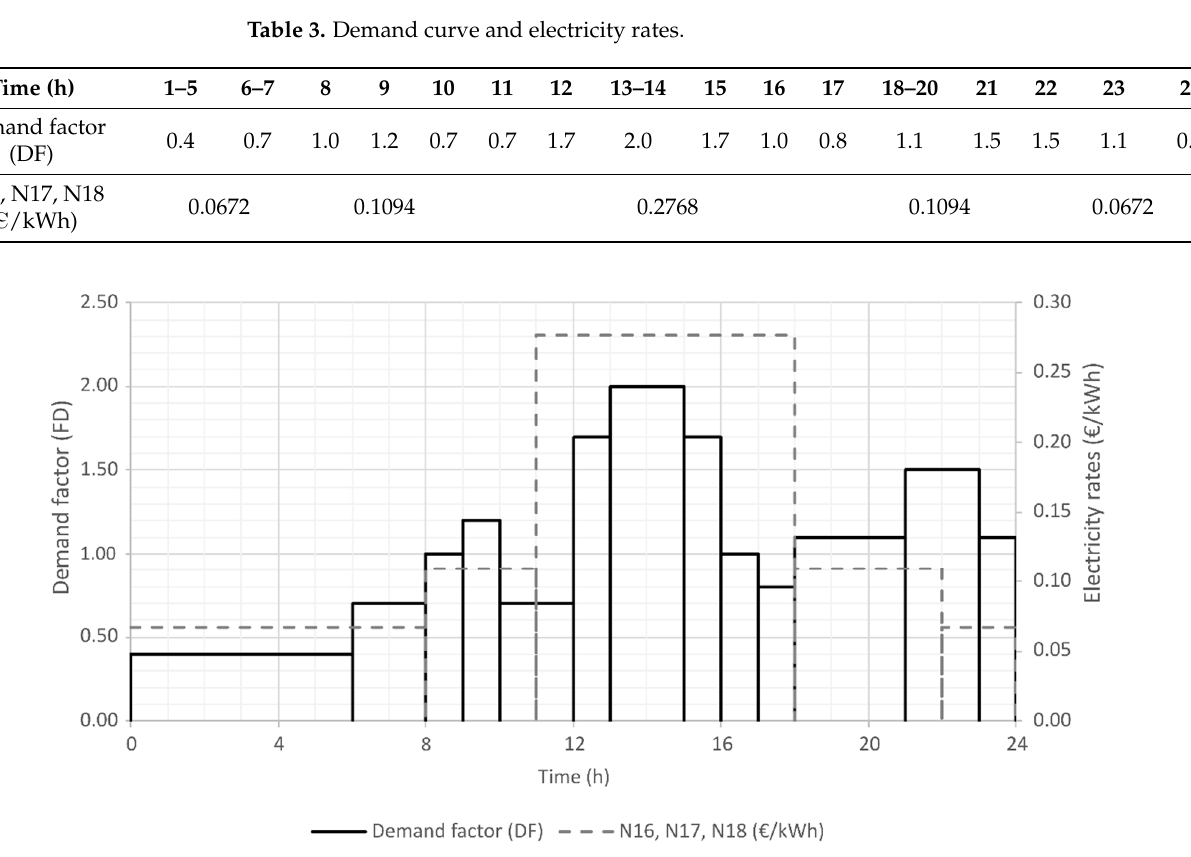
Figure 3. Demand pattern and electricity rates.